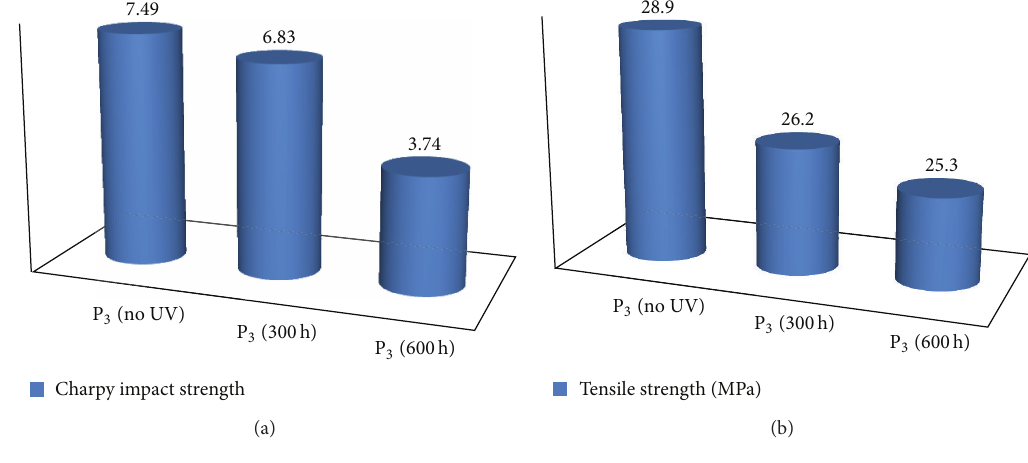
Figure 5: Charpy impact strength (a) and tensile strength (b).